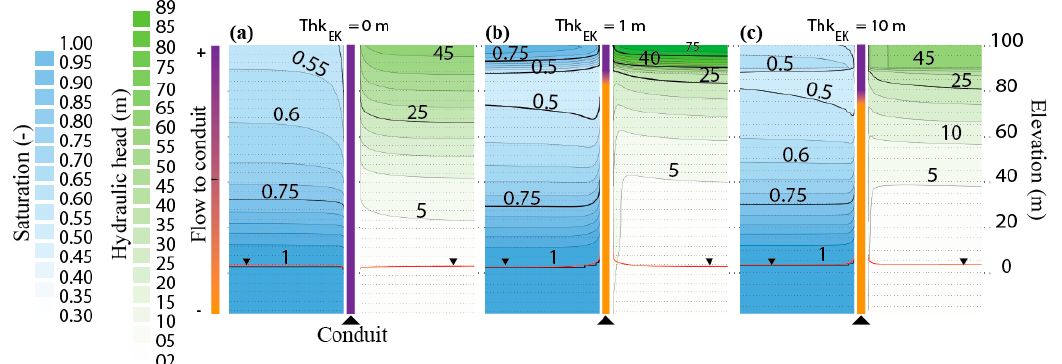
Figure 8. Profiles of saturation (blue) and hydraulic head (green) around the conduit for various thicknesses of the epikarst. Each profile is taken at the time step for which the flux at the bottom output of the model is maximum. ( a ) Model without an epikarst. ( b ) Model with a 1 m thick epikarst. ( c ) Model with a 10 m thick epikarst.